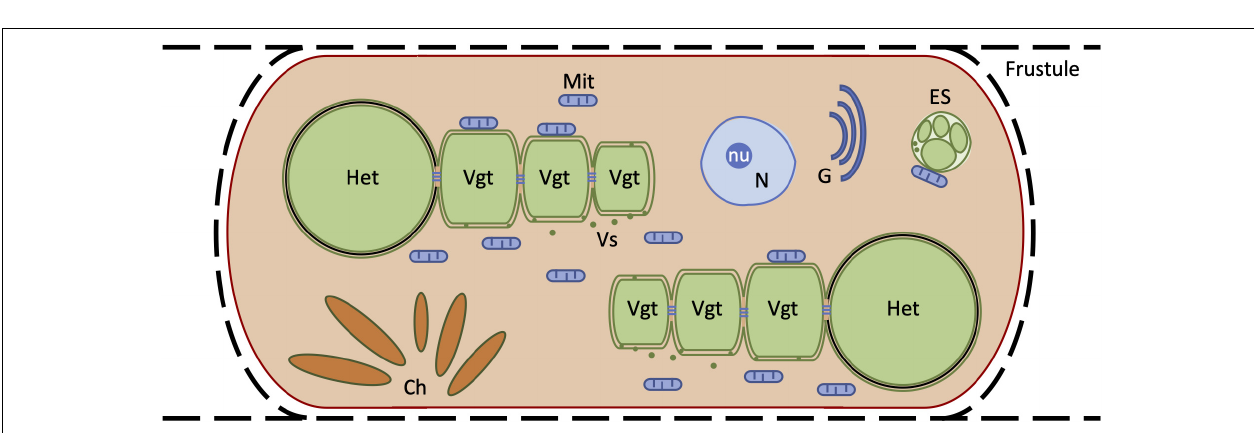
FIGURE 9 | Scheme of a symbiotic Hemiaulus hauckii cell. Two endosymbiotic filaments of Richelia intracellularis composed of one terminal heterocyst (Het) and three vegetative cells (Vgt) are represented, with emphasis in the distinction between cytoplasmic (inner) and outer membranes. The black line between these membranes in the heterocyst represents heterocyst-specific components of the cell wall that in Richelia intracellularis are periplasmic. Thin horizontal lines between cells represent the septal junctions that mediate intercellular molecular exchange in the cyanobacterial filament. Small green dots represent membrane vesicles (Vs), which may mediate transfer of cytoplasmic material from the cyanobacterium to the diatom. Internal structures of the cyanobacterial cells are not depicted. Numerous mitochondria (Mit) are present in the cytoplasm of the diatom, and some of them are tightly associated to cyanobacterial cells. A possible second endosymbiont (ES) with an associated mitochondrion is also depicted. The frustule, a nucleus (N) including a nucleolus (nu), Golgi bodies (G) and numerous chloroplast lobes (Ch) are also shown for the diatom. Depicted structures are not to